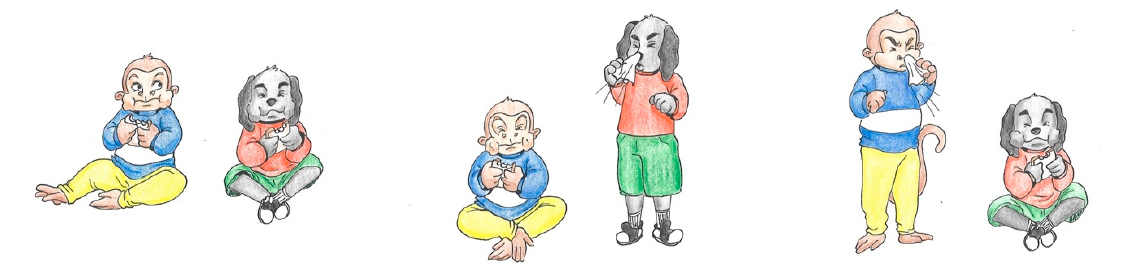
Figure A33. Filler stimulus 8.